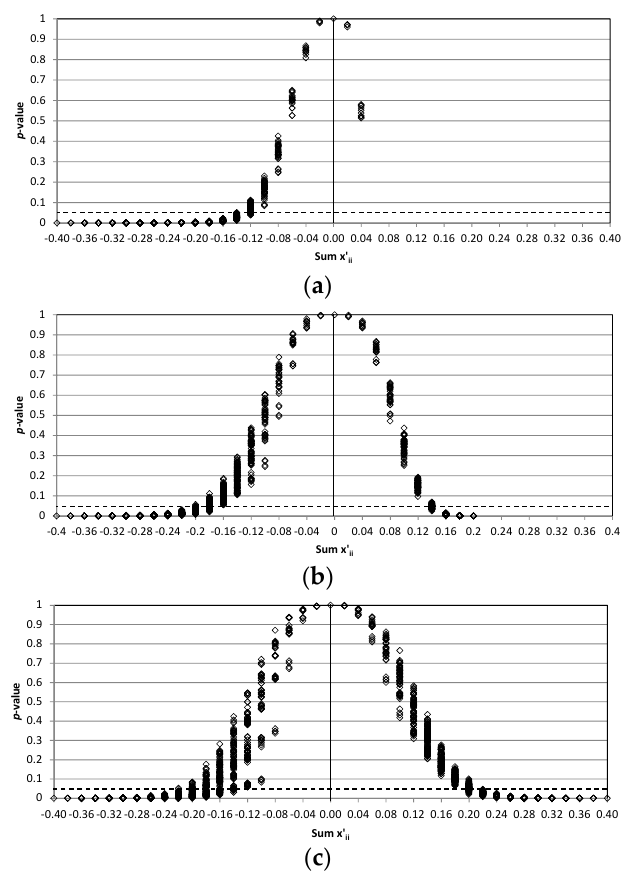
Figure 2. Representation of the p -value for each perturbed matrix. ( a – c ) are the results for CM 95 , CM 80 , and CM 50 , respectively. Cases in which the OA improves or worsens. The x -axis is the sum of the values of the perturbations. The dotted line represents a p -value of 0.05.